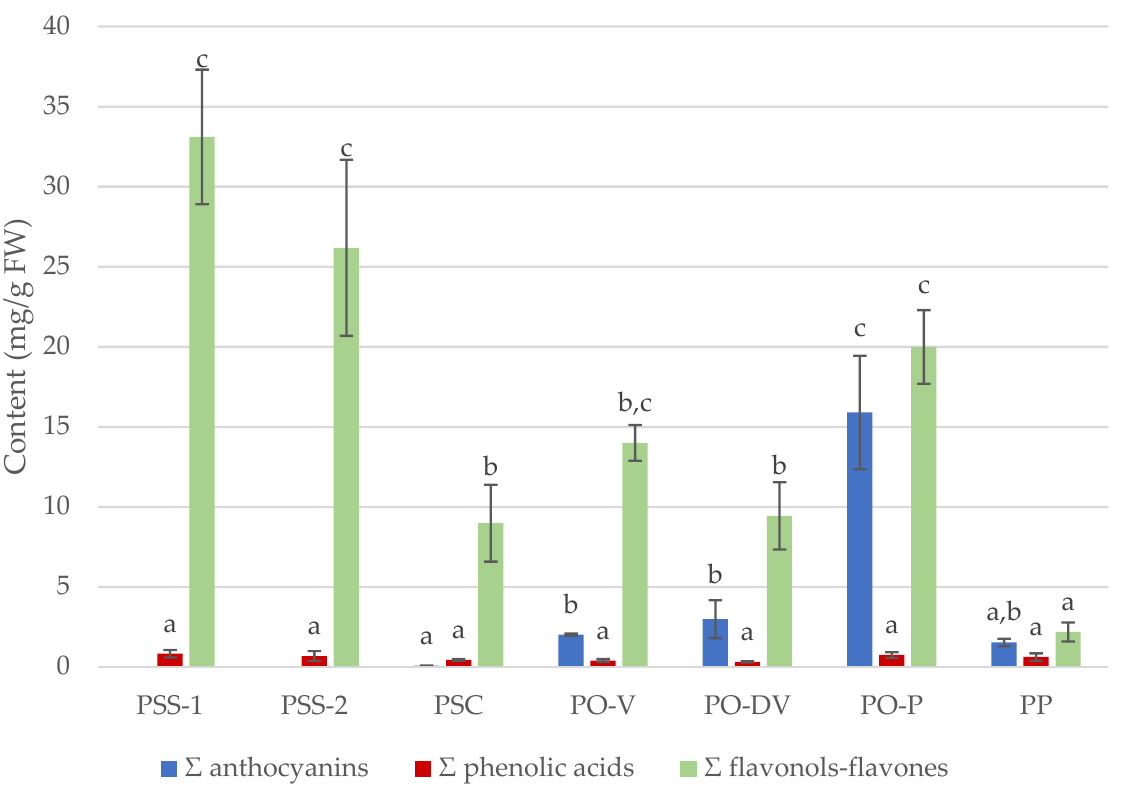
Figure 4. Total sum ( Σ ) of anthocyanin, phenolic acid and flavonol–flavone contents (mean ± SD, in mg/g FW) in different species of Phyteuma . Different letters indicate statistical differences between populations. PSS-1, P. spicatum ssp. spicatum populations growing alone; PSS-2, P. spicatum ssp. spicatum growing in sympatry with P. spicatum ssp. caeruleum ; PP, P. persicifolium ; PSC, P. spicatum ssp. caeruleum ; PO-V, P. ovatum populations with violet flowers; PO-DV, P. ovatum populations with dark violet flowers; PO-P, P. ovatum , populations with purple flowers. The lowest total flavonoid content was detected in blue-colored PP and purple-colored PO-P, and the highest in white-colored PSS. Regarding total anthocyanin content, purple- colored PO-P showed considerably highest values than any other population, followed by violet PO. Although there was no difference in any total contents between isolated and mixed populations of PSS (PSS-1 and PSS-2), significant differences were observed in total flavonoid content between the subspecies (PSS and PSC). PO showed intermediate values of total flavonoid content compared to PP and